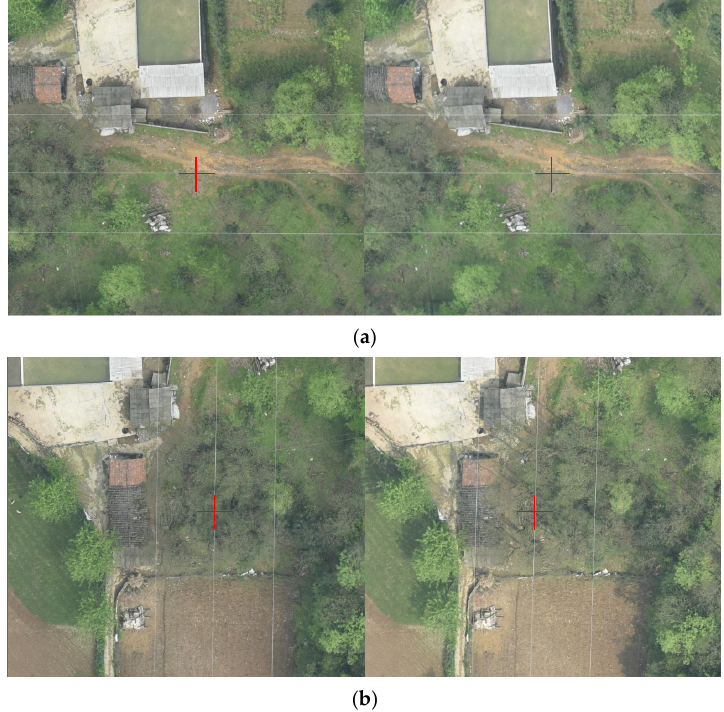
Figure 8. Stereo image pair for power line measurement. ( a ) Stereo image pair form inter-strips. ( b ) Stereo image pair form inter-strips.